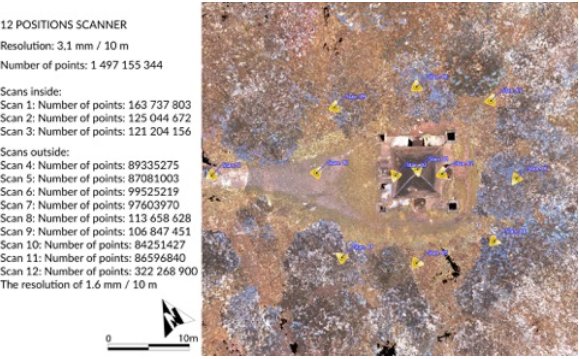
Figure 7. Location plan of scanner P30 stations (author: